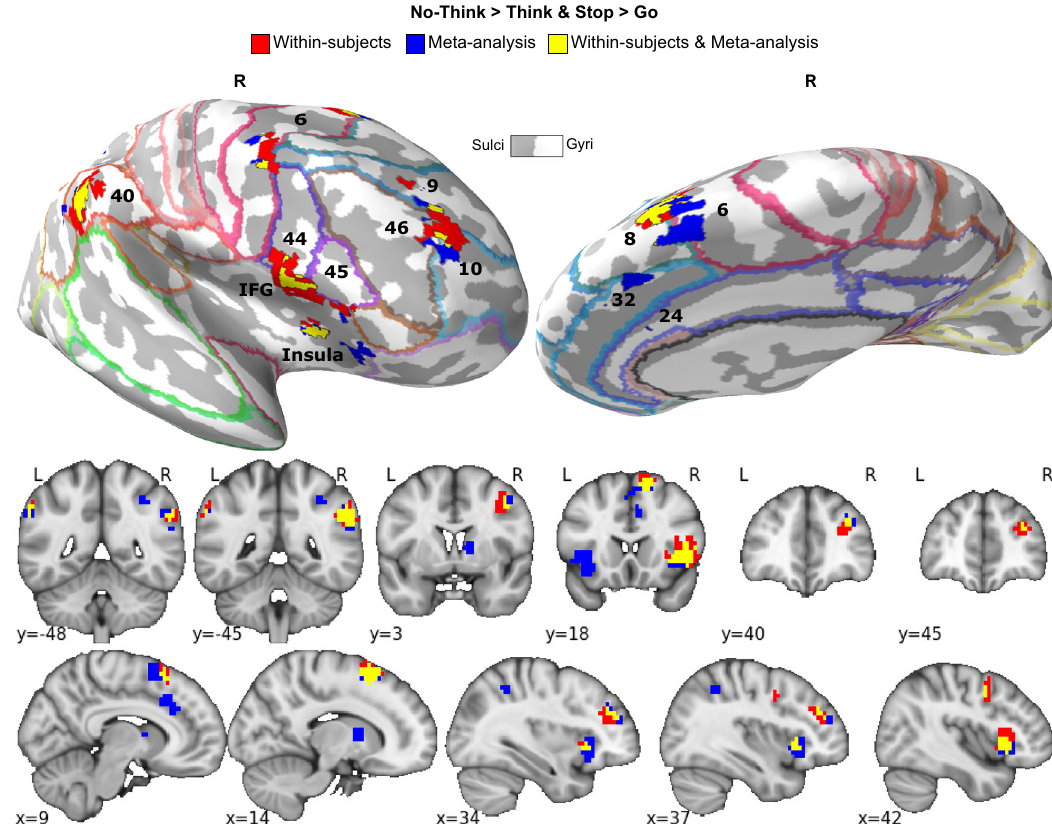
Fig. 3 Domain-general inhibition-induced activations. Red: within-subjects ( N = 24) conjunction of the Stop > Go and the No-Think > Think contrasts thresholded at p < 0.05 FDR corrected for whole-brain multiple comparisons. Blue: meta-analytic conjunction of Stop > Go and the No-Think > Think contrasts from independent 40 Stop-signal and 16 Think/No-Think studies. Yellow: overlap of the within-subjects and meta-analytic conjunctions. Results are displayed on an in fl ated MNI-152 surface with outlined and numbered Brodmann areas (top panel), as well as on MNI-152 volume slices (bottom panel). R: right hemisphere; L: left hemisphere. The brain images were generated using FreeSurfer software (http://surfer.nmr.mgh.harvard.edu), and PySurfer (https://pysurfer.github.io) and Nilearn (https://nilearn.github.io) Python (Python Software Foundation, DE, USA) packages. Conjunction maps and visualisation notebook are available on the GitHub repository 104